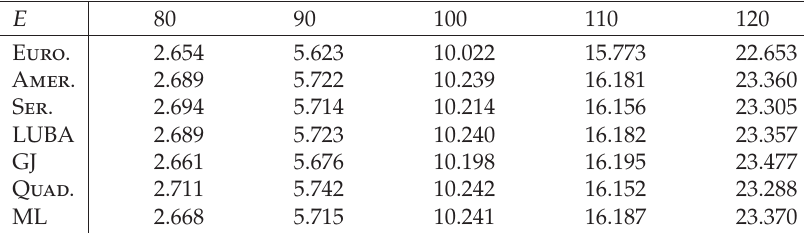
Table 2.11 . Put: Comparison with other methods; τ = 0 . 5, S r = 0 . 07, D = 0 . 03, and σ = 0 . 4. Ser is the value of an American op- 0 tion computed using using a 100,000 path Monte Carlo simulation taking series ( 1.4 ) as the exercise boundary. Other columns are as in